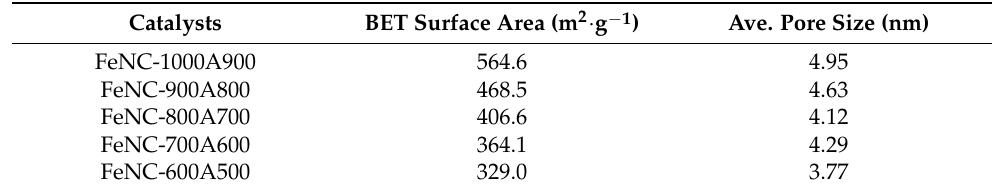
Table 3. Specific area and average pore sizes of FeNCs.